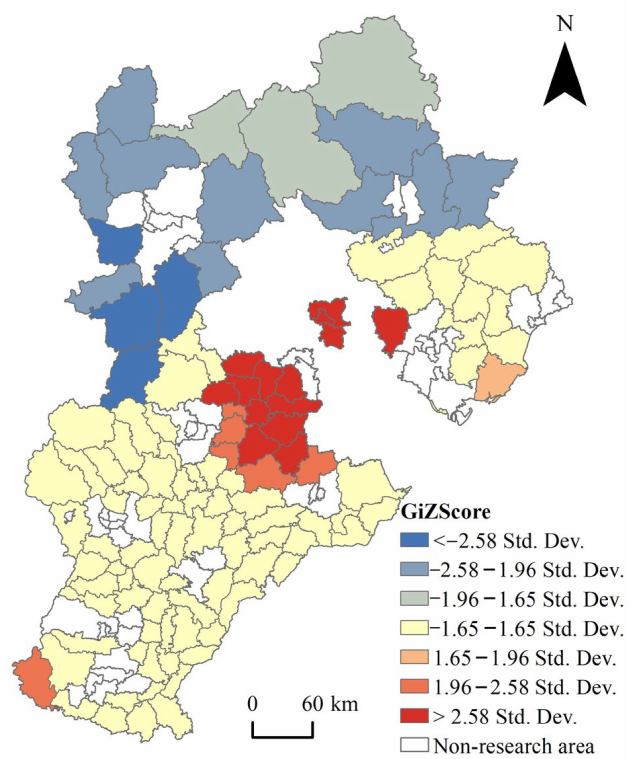
Figure 4. Hot and cold spots in urban land-average carbon emissions distribution.